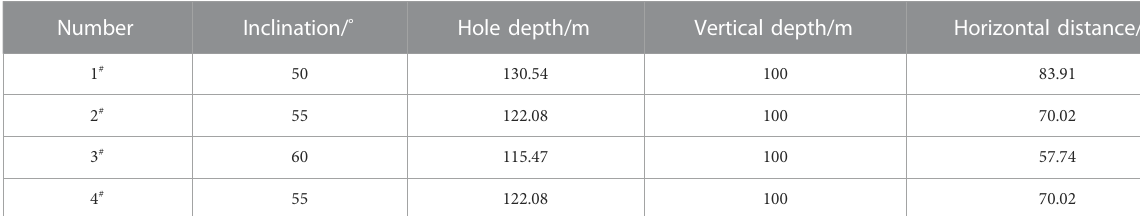
TABLE 1 Drilling design